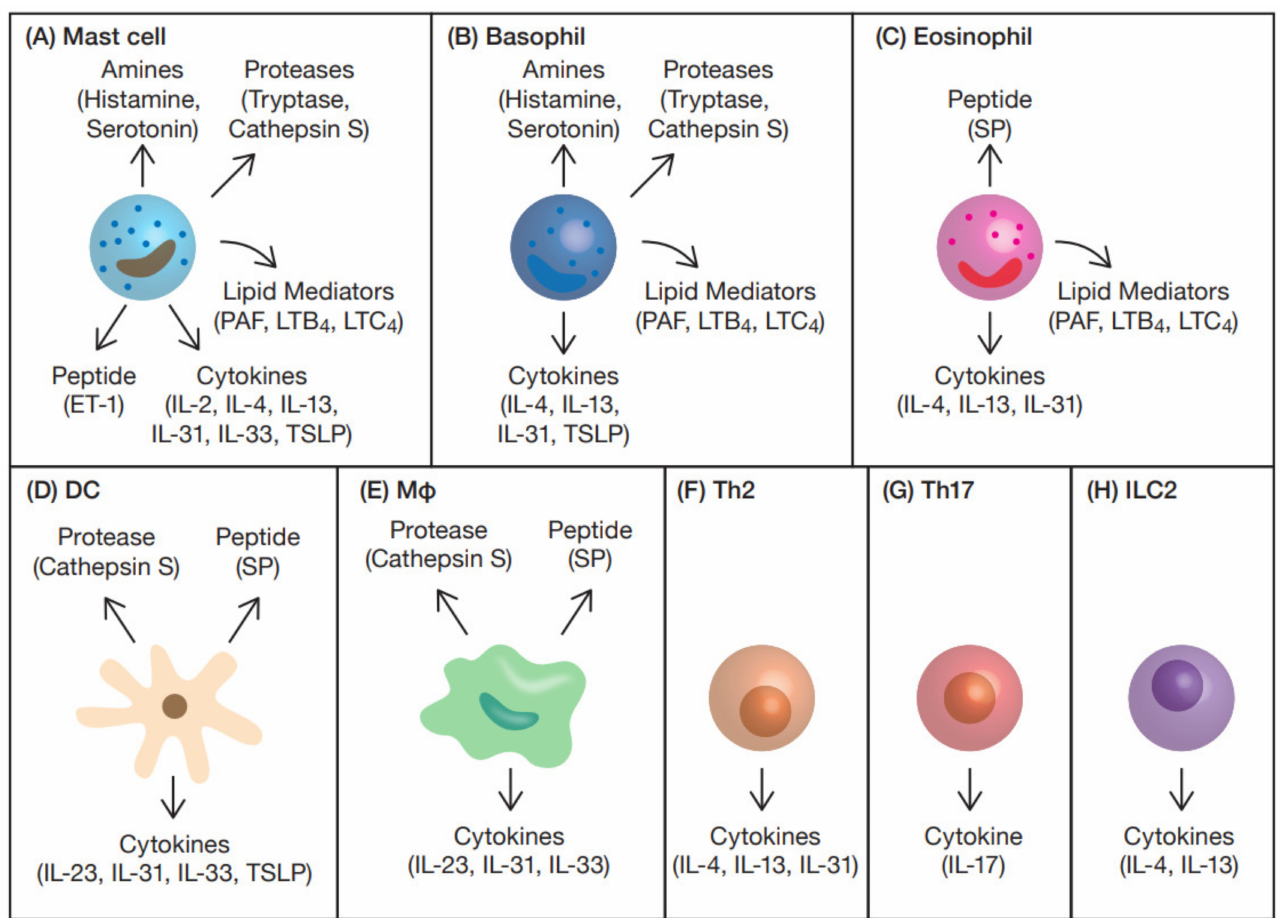
Figure 2. Immune cells and itch mediators and modulators. ( A ) Mast cells produce amines (histamine and serotonin), proteases (tryptase and cathepsin S), peptide (ET-1), cytokines (IL-2, IL-4, IL-13, IL-31, IL-33 and TSLP) and lipid mediators (PAF, LTB 4 , and LTC 4 ). ( B ) Basophils produce amines (histamine and serotonin), proteases (tryptase and cathepsin S), cytokines (IL-4, IL-13, IL-31 and TSLP) and lipid mediators (PAF, LTB 4 and LTC 4 ). ( C ) Eosinophils produce peptide (SP), cytokines (IL-4, IL-13 and IL-31) and lipid mediators (PAF, LTB 4 , LTC 4 ). ( D ) DCs produce protease (cathepsin S), peptide (SP) and cytokines (IL-23, IL-31, IL-33 and TSLP). ( E ) Macrophages produce protease (cathepsin S), peptide (SP) and cytokines (IL-23, IL-31 and IL-33). ( F ) Th2 cells produce cytokines (IL-4, IL-13 and IL-31). ( G ) Th17 cells produce the cytokine IL-17. ( H ) ILC2 cells produce cytokines (IL-4 and